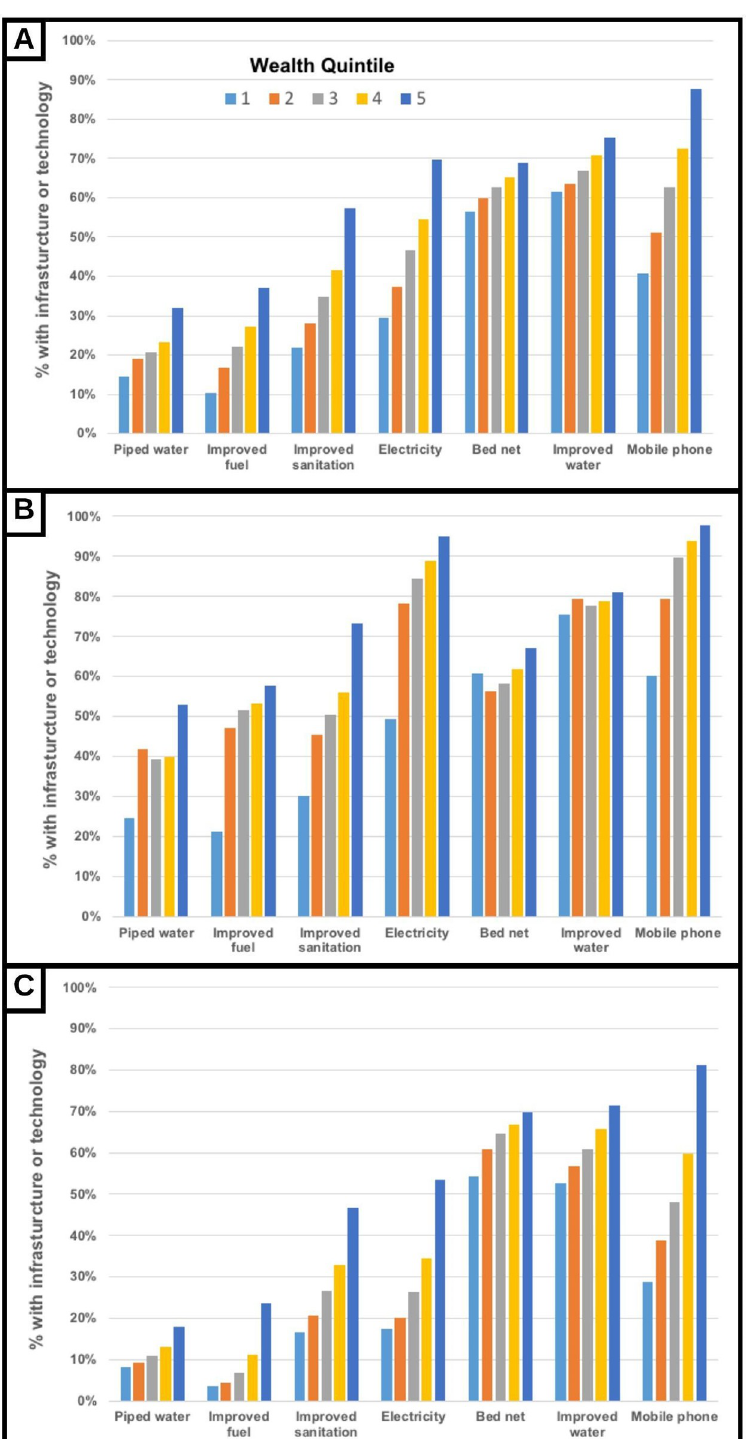
Fig 1. A) Relationship between wealth quintile and coverage with different environmental health assets for all households; B) Relationship between wealth quintile and coverage with different environmental health assets for urban households; C) Relationship between wealth quintile and coverage with different environmental health assets for rural households.